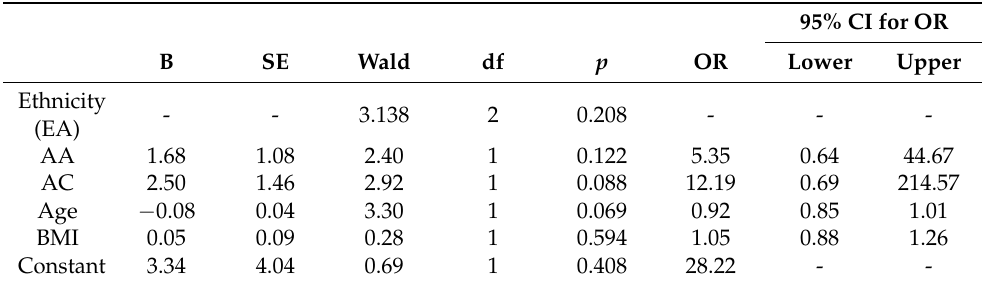
Table 2. Binary logistic regression of ethnic differences across physical activity trends while controlling for age and BMI ( n = 62).